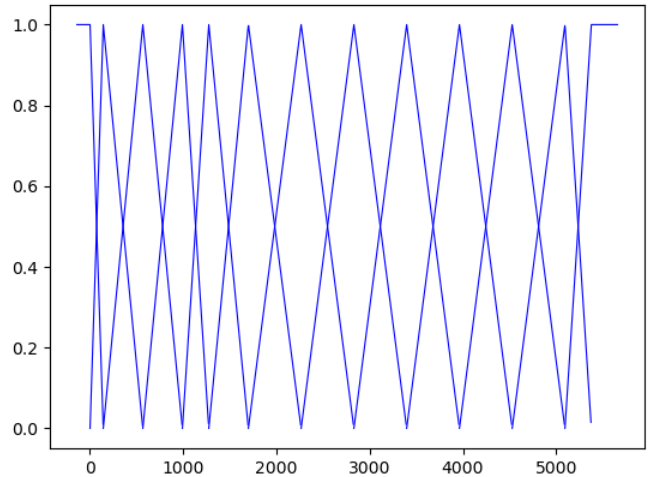
Figure 2. Triangular membership function clusters obtained after pruning.